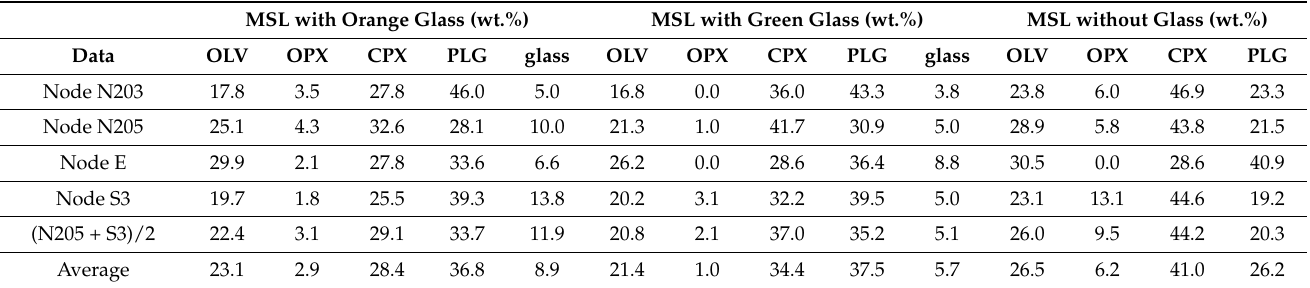
Table 5. Mineral abundances (wt.%) were retrieved by comparing CE-3 data and the MSL with green/orange glass. MSL with Orange Glass (wt.%) MSL with Green Glass